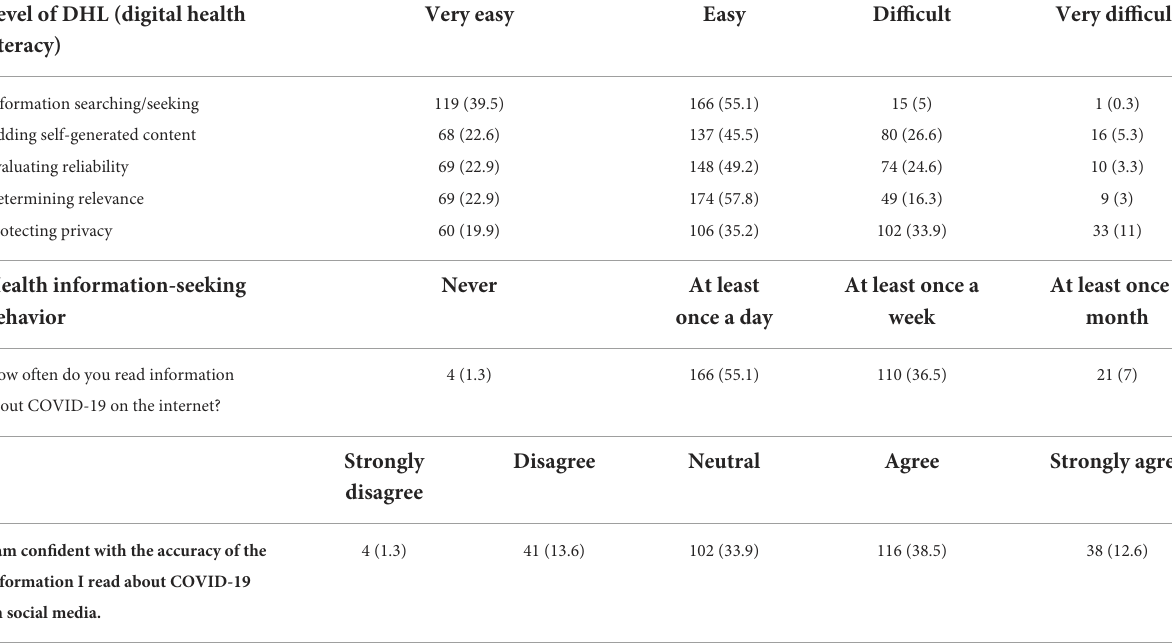
TABLE 1 Digital health literacy and health information seeking behavior of participants ( n = 301). Level of DHL (digital health